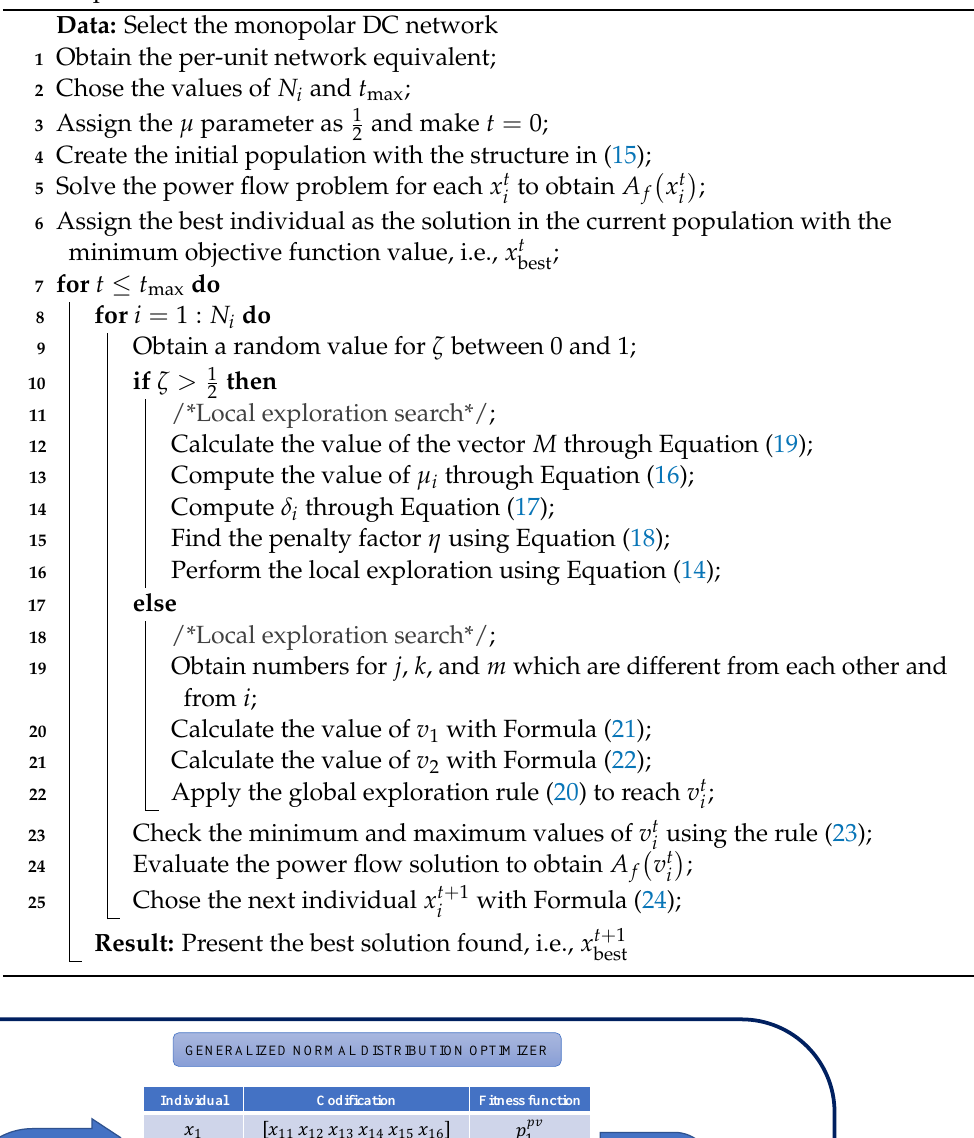
Algorithm 1: Application of the GNDO method to locate and size PV sources in monopolar DC networks.